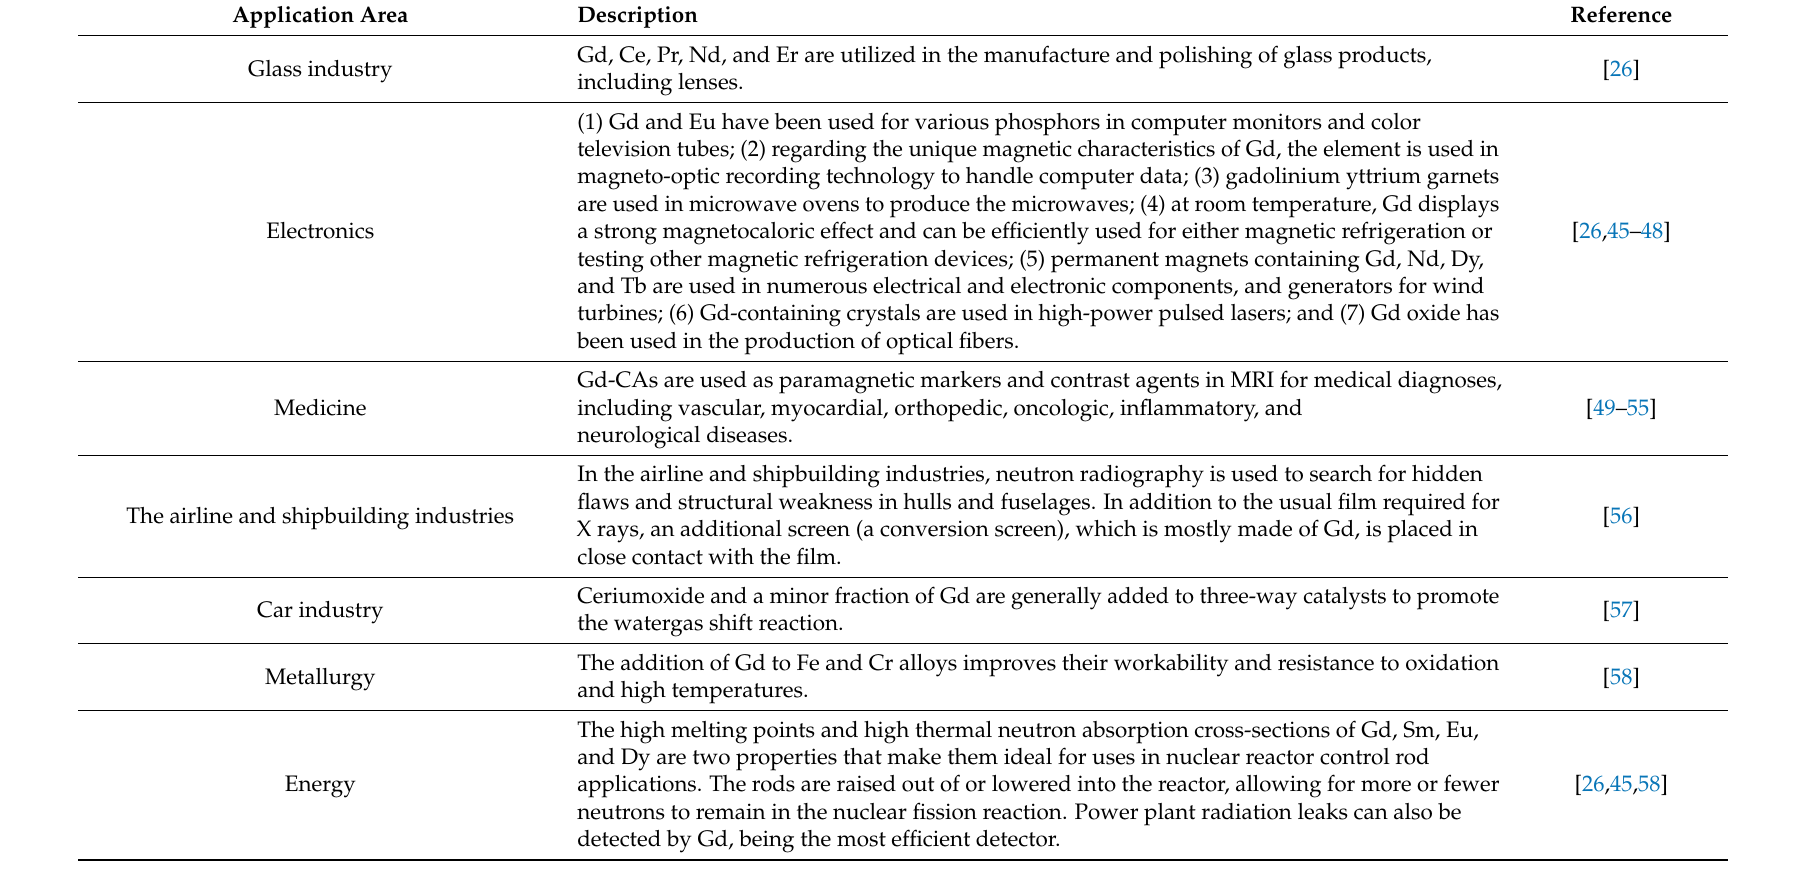
Table 1. Different high-technology applications of